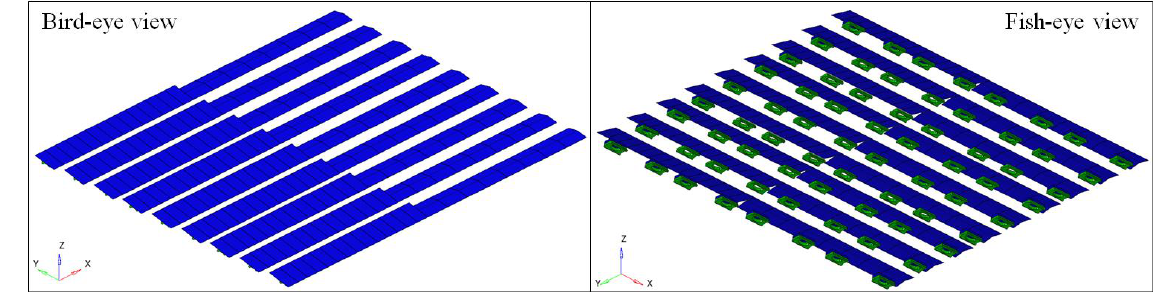
Figure 3. Configuration of the floating PV plant composed of four sub-plants. Table 2. Summary of panel elements.